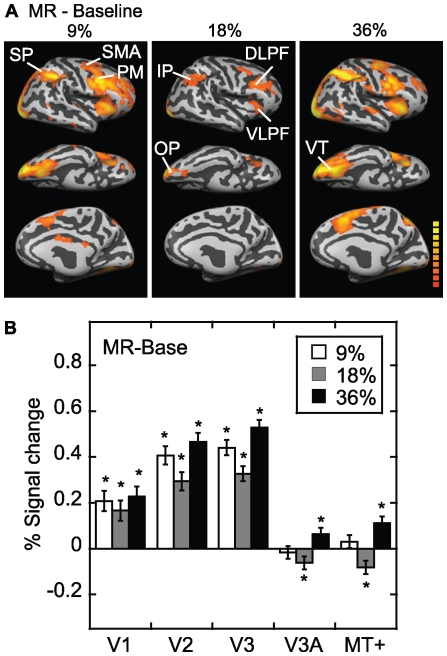
Monocular rivalry minus blank baseline.(A) Activation for monocular rivalry (MR) with grating stimuli above the blank baseline condition at the three contrasts (9%, 18%, 36%). The lateral, ventral and medial views of the inflated brain are shown (right hemisphere only). Colour scale on this and subsequent Figures indicates statistically significant results ranging from t = 2.35 to 8.00 (orange-yellow) (FDR, p<0.05). Monocular rivalry showed a U-shaped function of activation as a function of contrast; there was higher activation in a number of different areas at 9% and 36%. Abbreviations: dorsolateral prefrontal cortex (DLPF); inferior parietal cortex (IP); occipital pole (OP); premotor cortex (PM); superior parietal cortex (SP); supplementary motor area (SMA); ventral temporal (VT); ventrolateral prefrontal cortex (VLPF). (B) Region of interest analysis for monocular rivalry, in terms of percent signal change above the blank baseline condition (average of six subjects). The results are shown for gratings at the three contrasts (9%, 18%, 36%). The analysis for areas V1, V2 and V3 was carried out only in the foveal part of each area (0–2.9 deg eccentricity). Generally, the results did not differ between the left and right hemisphere, and have been averaged. Statistically significant results (p<0.05) in this and subsequent Figures are labeled with an asterisk. As in panel (A), monocular rivalry showed a U-shaped function of activation as a function of contrast in many areas, particularly V2 and V3.